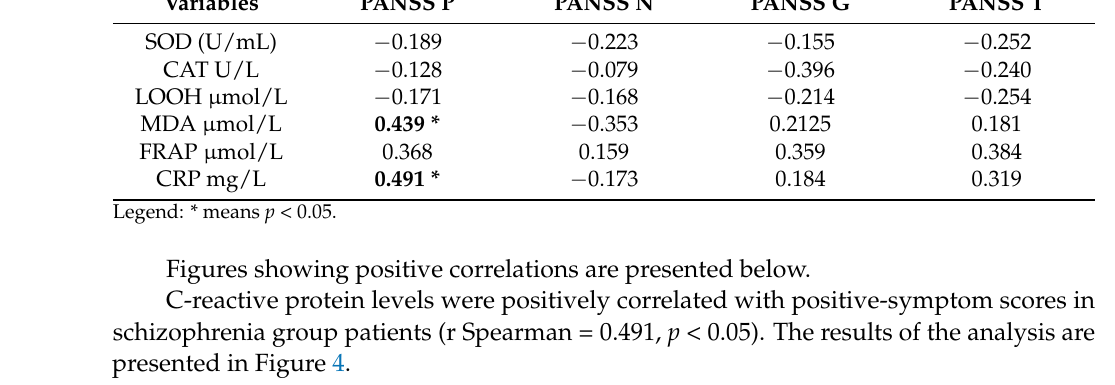
Table 3. The results of the analysis of the correlation between the studied variables and the results of the PANSS scale. PANSS total, Positive and Negative Syndrome Scale for Schizophrenia total score; PANSS-P, Positive Scale; PANSS-N, Negative Scale; PANSS-G, General Psychopathology Scale. Variables PANSS P